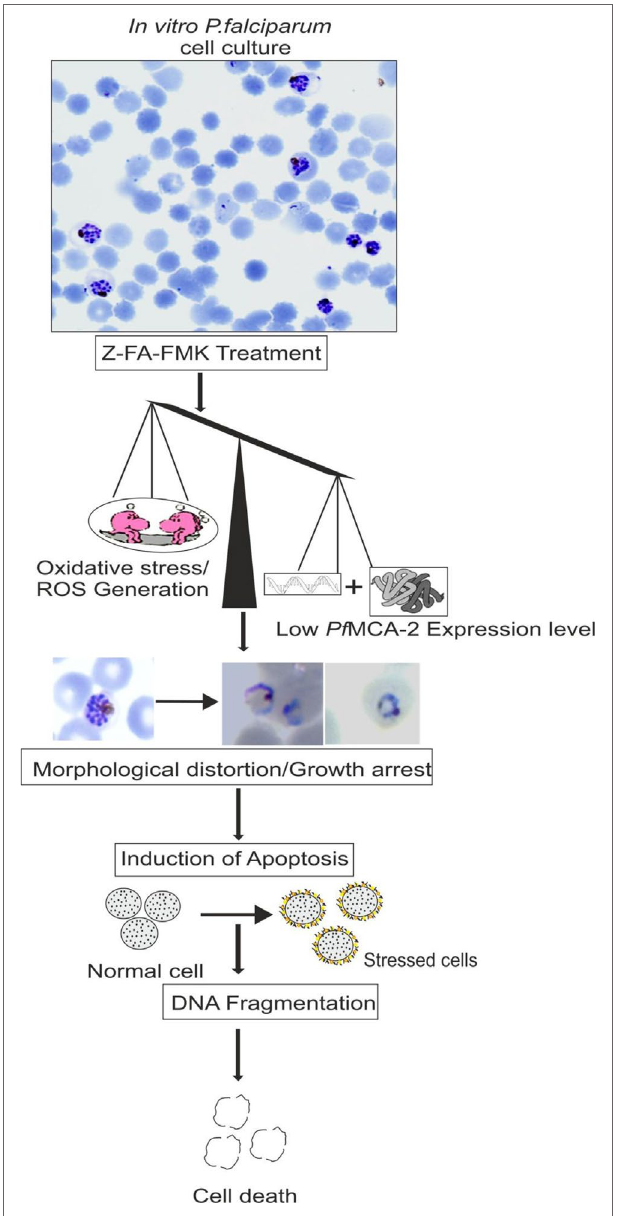
FIGURE 6 | Schematic proposed model for Pf MCA-2 dependent apoptosis- like cell death in vitro induced by Z-FA-FMK (a known inhibitor of effector caspases) (Vandana et al.,